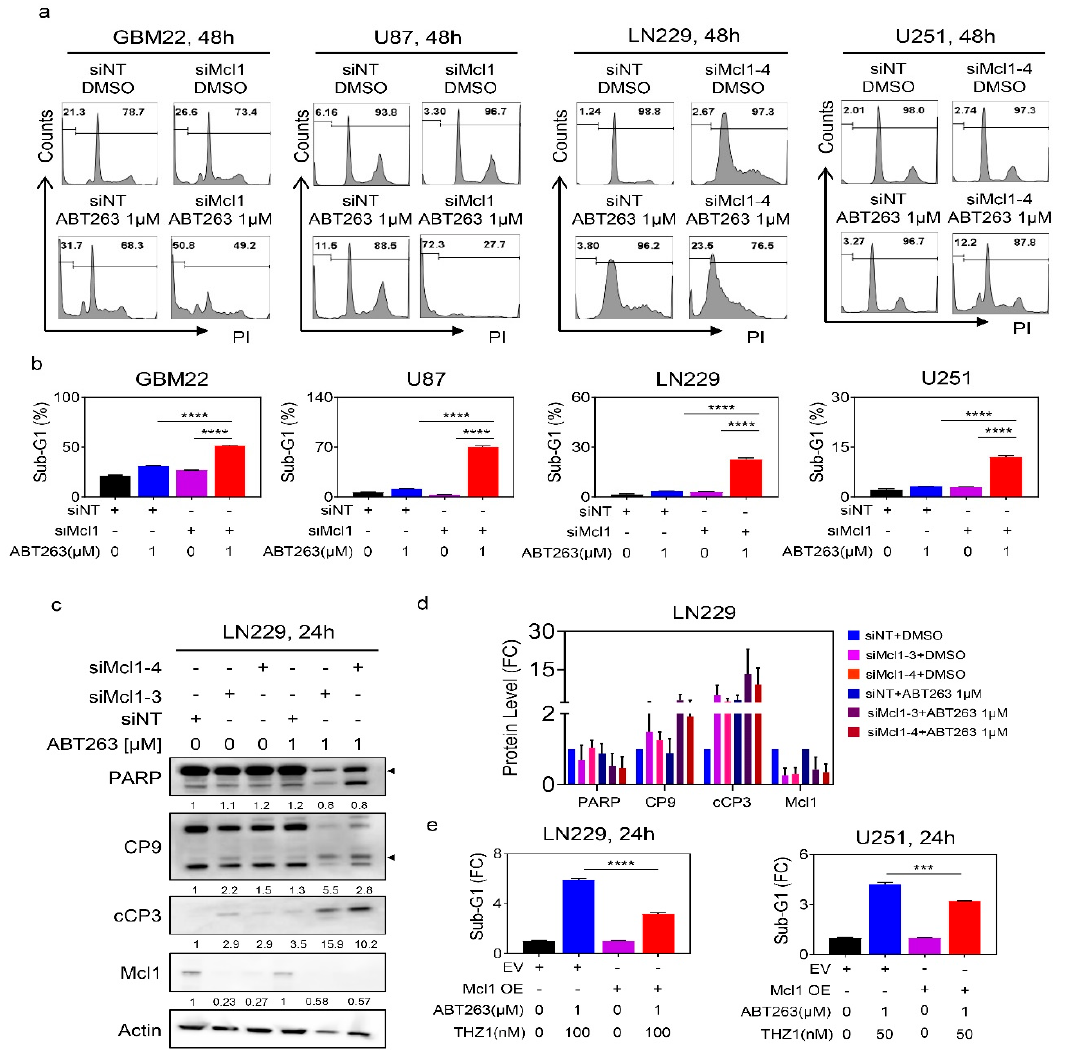
Figure 5. Down-regulation of Mcl-1 is necessary and su ffi cient for the combination treatment of ABT263 and THZ1 to exert its killing e ff ects on GBM cells. ( a ) Shown are representative flow plots of GBM22, U87, LN229, and U251 cells transfected with control (siNT) or specific Mcl1 siRNAs, treated with ABT263, and labeled with propidium iodide followed by flow cytometry to detect the sub-G1 fraction; ( b ) The graphs show the Sub-G1 fraction of GBM22, U87, LN229, and U251 cells transfected with control (siNT) or specific Mcl1 siRNAs and subsequent treatment with vehicle or ABT263 ( n = 3). ANOVA was used for statistical analysis; ( c ) Standard western blots of cell lysates of LN229 cells that were transfected with control (siNT) or two specific Mcl-1 siRNAs and were treated with DMSO or 1 µ M ABT263. The protein expression levels were quantified using ImageJ (shown in cursive font). Arrow heads show the quantification of the protein levels of total PARP and cleaved CP9. Uncropped blots are shown in Figure S10; ( d ) The protein expression levels of PARP, CP9, cCP3, and Mcl1 of LN229 cells that were transfected with control (siNT) or two specific Mcl-1 siRNAs and were treated with DMSO or 1 µ M ABT263 ( n = 2–3). FC: fold change; ( e ) LN229 and U251 cells were transfected with empty vector or Mcl1 over-expressing vector and were treated with the combination of ABT263 and THZ1 for 24 h. Cells were labeled with propidium iodide and the quantifications are provided. Shown are means and SD. Statistical significance was determined by two-tailed Student’s t-test. *** / **** p < 0.001.